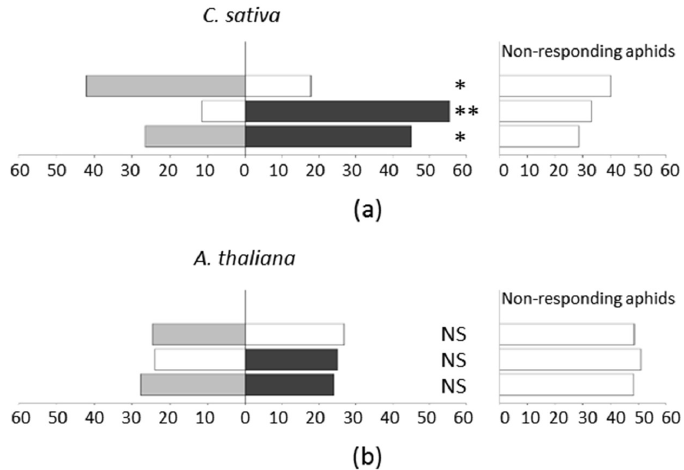
Figure 4. Distribution of apterous M. persicae in the darkened bioassay arena. ( a ) C. sativa ; ( b ) A. thaliana . Mock-inoculated plants (grey bars) and TuYV-infected plants (black bars) were tested versus either the blank (white bars) or the opposite modality. The bars on the left represent the percentage of responding aphids that were arrested under either a plant or an empty pot (Blank). The bars on the right represent the percentage of non-responding aphids still walking in the arena. Asterisks indicate a significant difference (* p -value < 0.05; ** p -value < 0.01) in the distribution of aphids between the two sides of the darkened arena. NS, not significant.